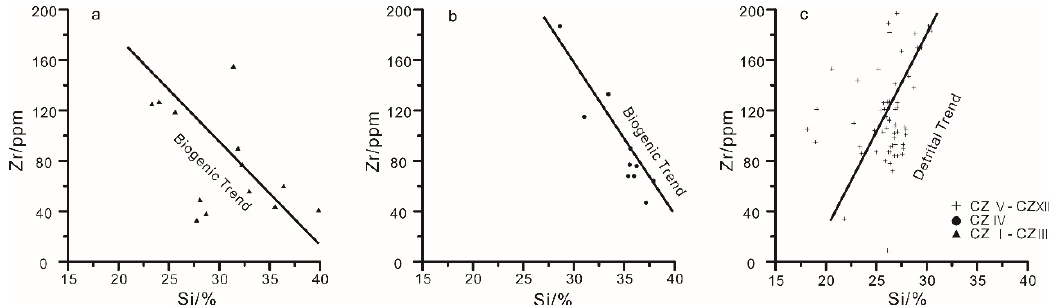
Figure 7. Si-Zr scatter plot of different chemozones along the Changning section. ( a ) Samples from the Wufeng Formation or CZ I–CZ III, ( b ) samples from the bottom of the Lower Longmaxi Formation or CZ Ⅳ , ( c ) samples from the Lower Longmaxi Formation or CZ Ⅴ –CZ Ⅻ .